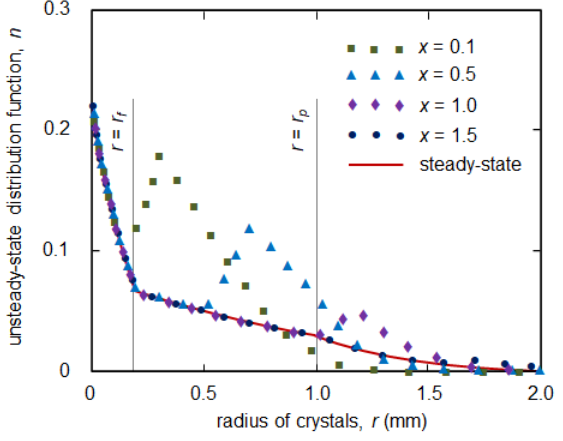
Figure 3. The unsteady-state particle-radius distribution at different decision variables x (symbols) and the steady-state distribution function (solid line). System parameters correspond to Figure 2 with b = g = 1. The initial distribution function n 0 was chosen as a normal (Gaussian) distribution with a standard deviation of 0.4 and zero